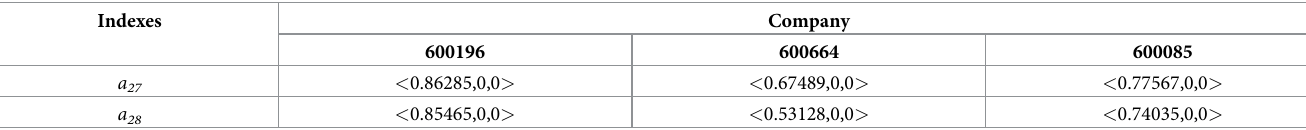
Table 9. Evaluation values of financial risk by decision makers.